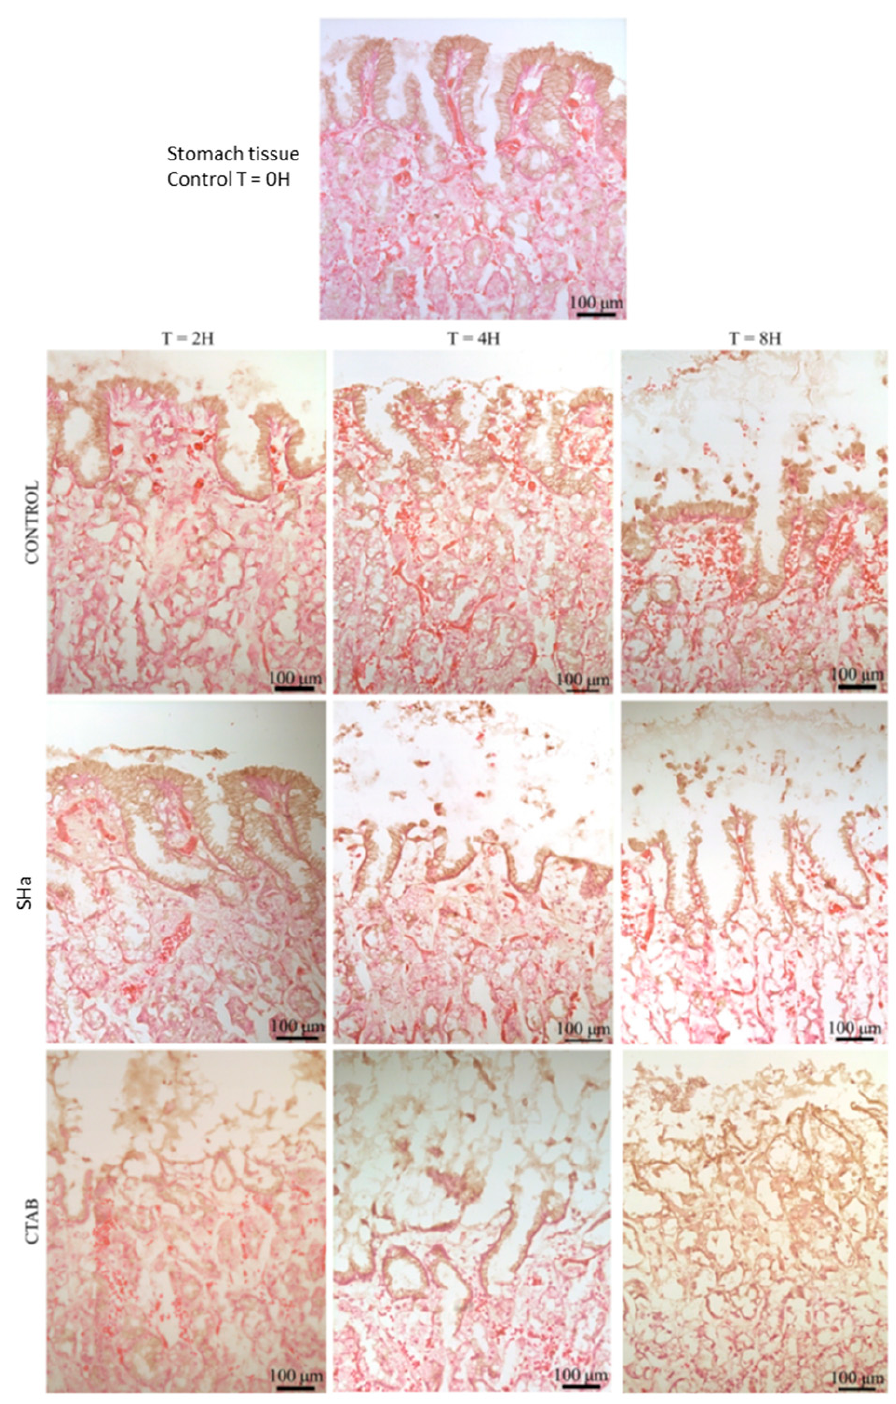
Figure 10. Histological examination of human stomach tissue treated with temporin-SHa. Human gastric explants were treated with temporin-SHa (100 µ M) or CTAB (300 µ M) as positive control of tissue damages for 2, 4, 8 h before H&E staining and microscopic observations as explained in Materials and Methods. Images shown are representative of e ff ects observed in